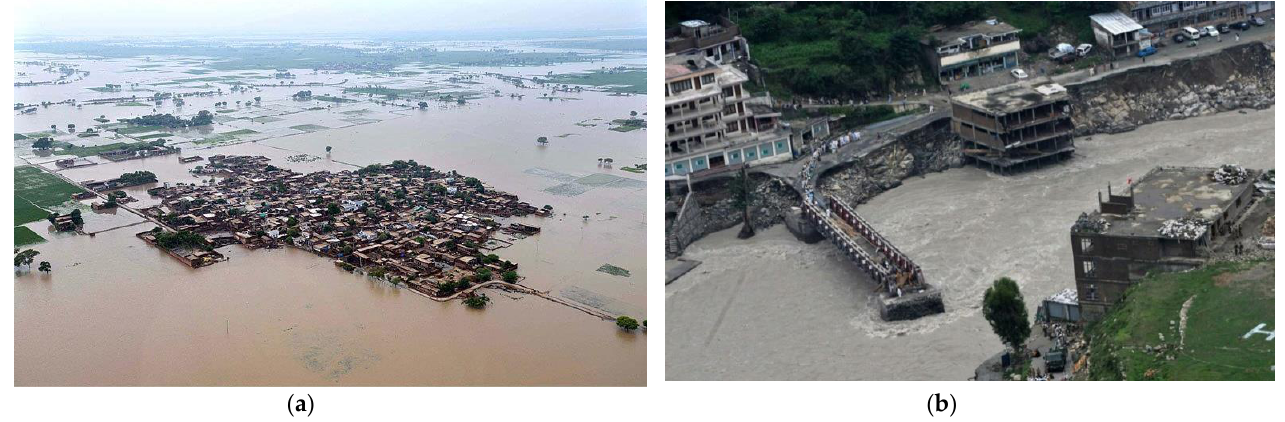
Figure 4. Flooded regions of Swat Valley. ( a ) A village ( b ) A damaged bridge